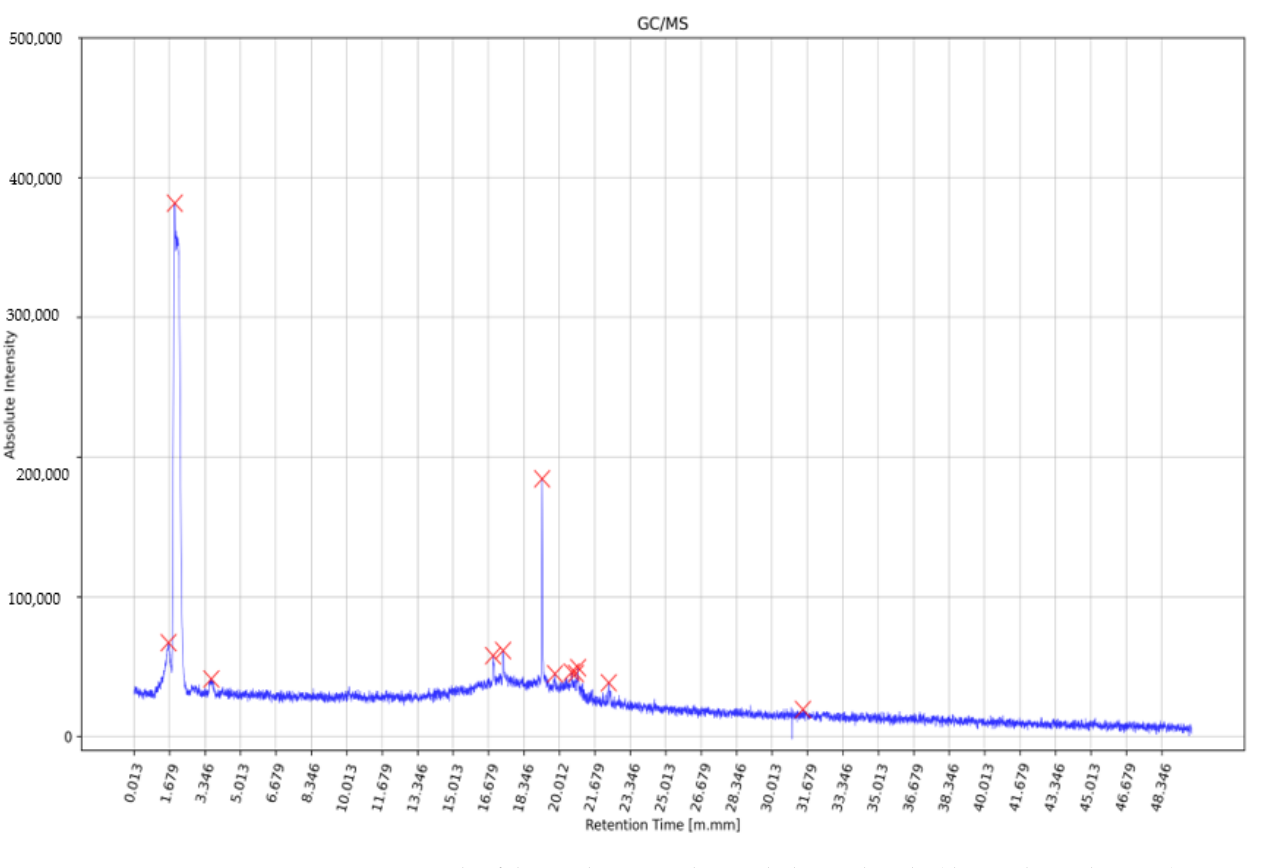
Figure 3. The data obtained in this way formed the basis for the next step: cluster analysis